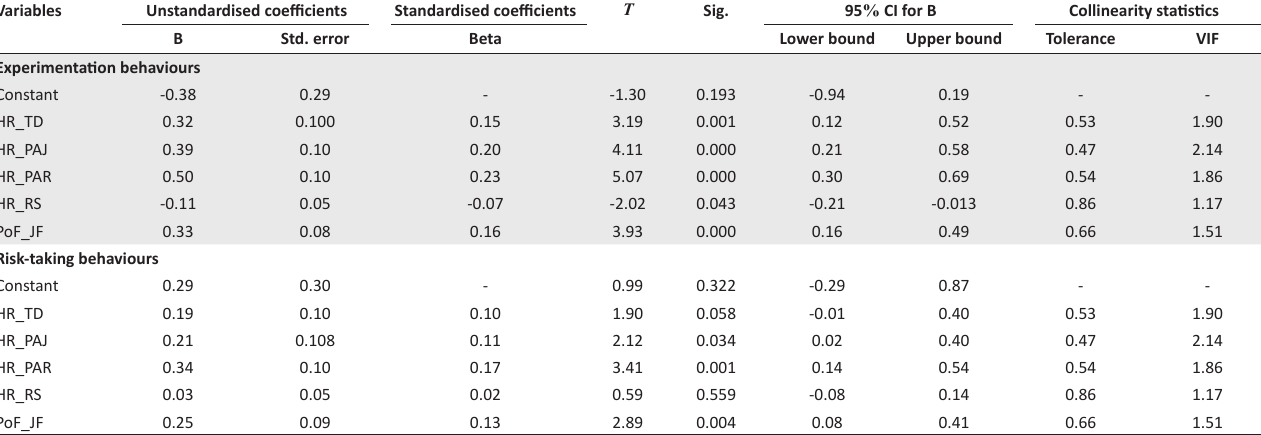
TABLE 5: Unique contribution indicated by the coefficients. Variables Unstandardised coefficients